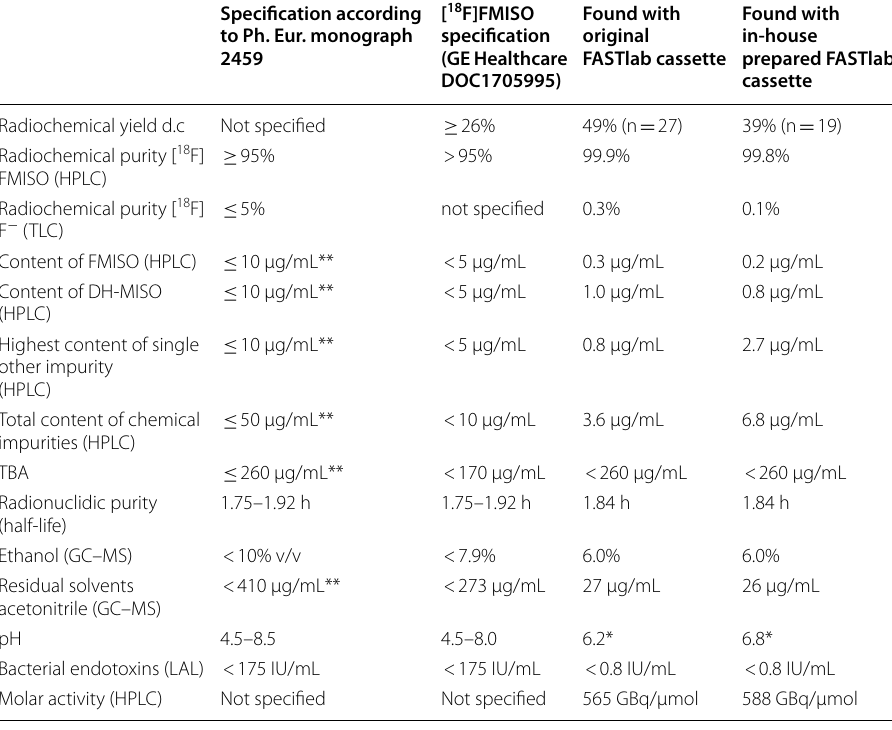
*After addition of 2.0 mL E153 solution for